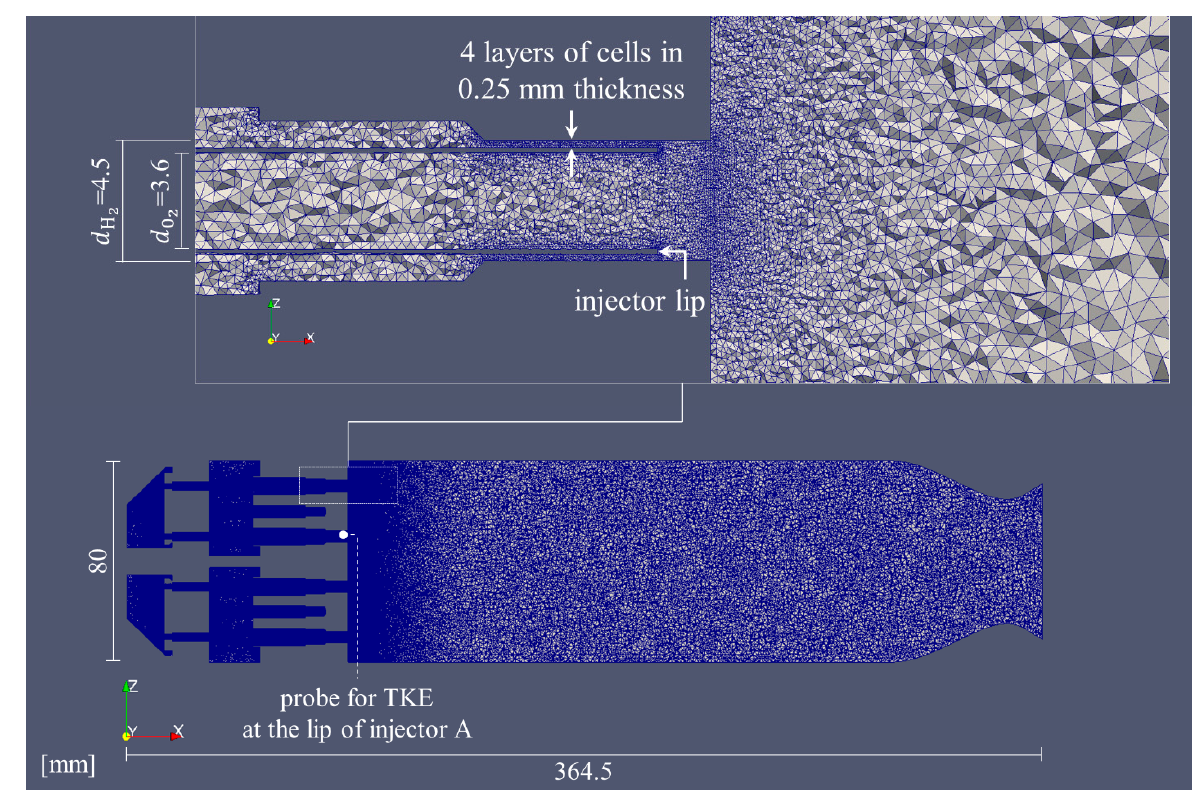
Figure 2. Grid overview with close-up view of the injection region along with the location of the probe to measure the turbulent kinetic energy (TKE) signal. Energies 2021 , 14 , x FOR PEER REVIEW 8 of 24